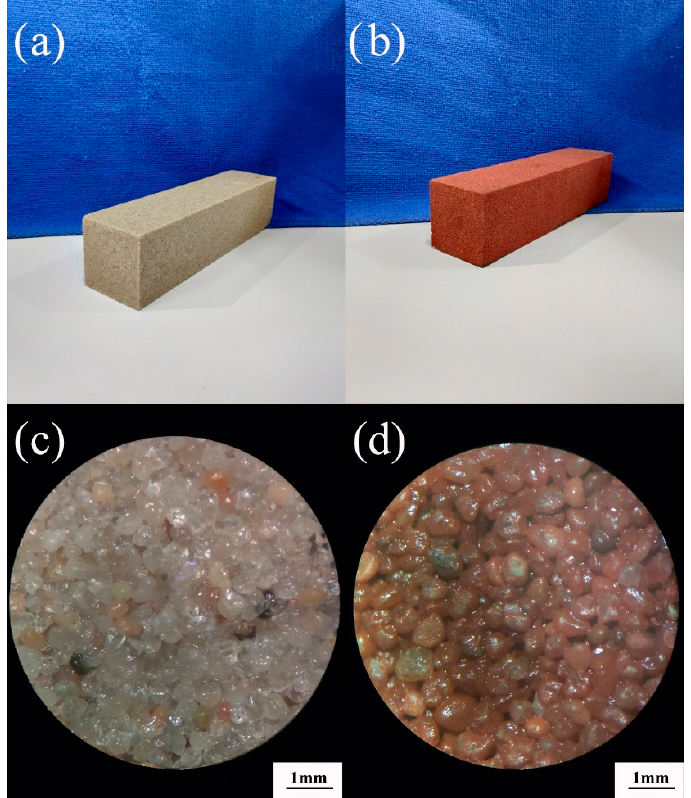
Figure 15. Photos of bricks before grinding: ( a ) permeable brick before dyeing; ( b ) permeable brick after dyeing; ( c ) micrograph of permeable brick before dyeing; ( d ) micrograph of permeable brick after dyeing.